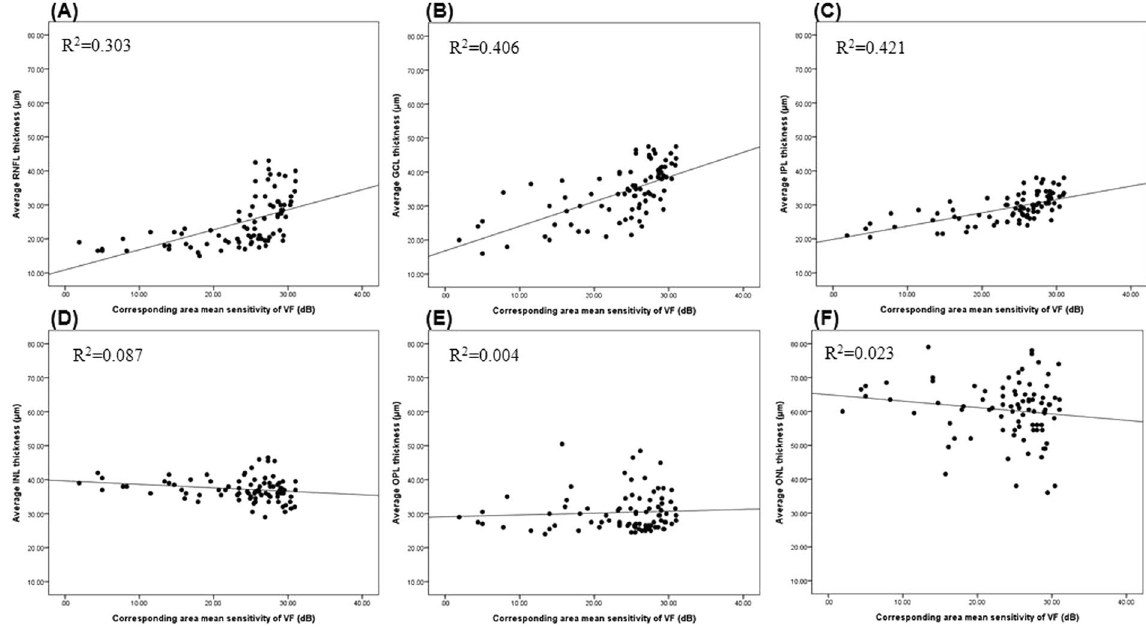
Figure 3. Scatterplots illustrating the linear correlation between standard automated perimetry (SAP) mean sensitivity (MS) value (dB) and spectral domain optical coherence tomography (SD-OCT) segmented retinal thicknesses in the macular area. ( A ) Average RNFL thickness versus corresponding area MS (R 2 = 0.303, p < 0.001). ( B ) Average GCL thickness versus corresponding area MS (R 2 = 0.406, p < 0.001). ( C ) Average IPL thickness versus superior corresponding area MS (R 2 = 0.421, p < 0.001) ( D ) Average INL thickness versus corresponding area MS (R 2 = 0.087, p = 0.006). ( E ) Average OPL thickness versus corresponding area MS (R 2 = 0.004, p = 0.553). ( F ) Average ONL thickness versus corresponding area MS (R 2 = 0.023, p = 0.169). RNFL = retinal nerve fiber layer; GCL = ganglion cell layer; IPL = inner plexiform layer; INL = inner nuclear layer; OPL = outer plexiform layer; ONL = outer nuclear layer.